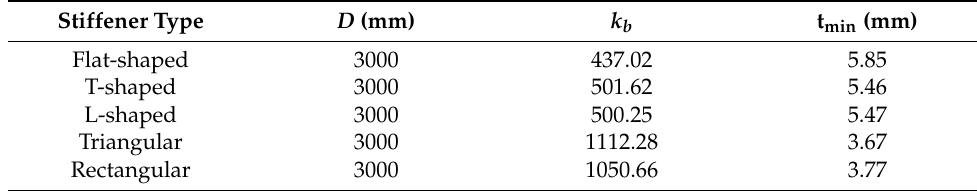
Table 4. Comparison of minimum stiffened web